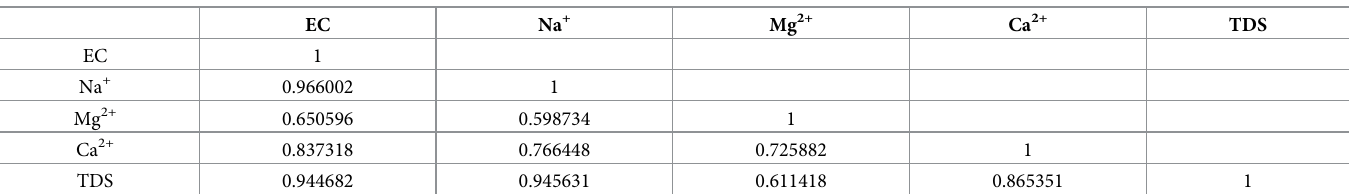
Table 6. Correlation matrix from raw wastewater.